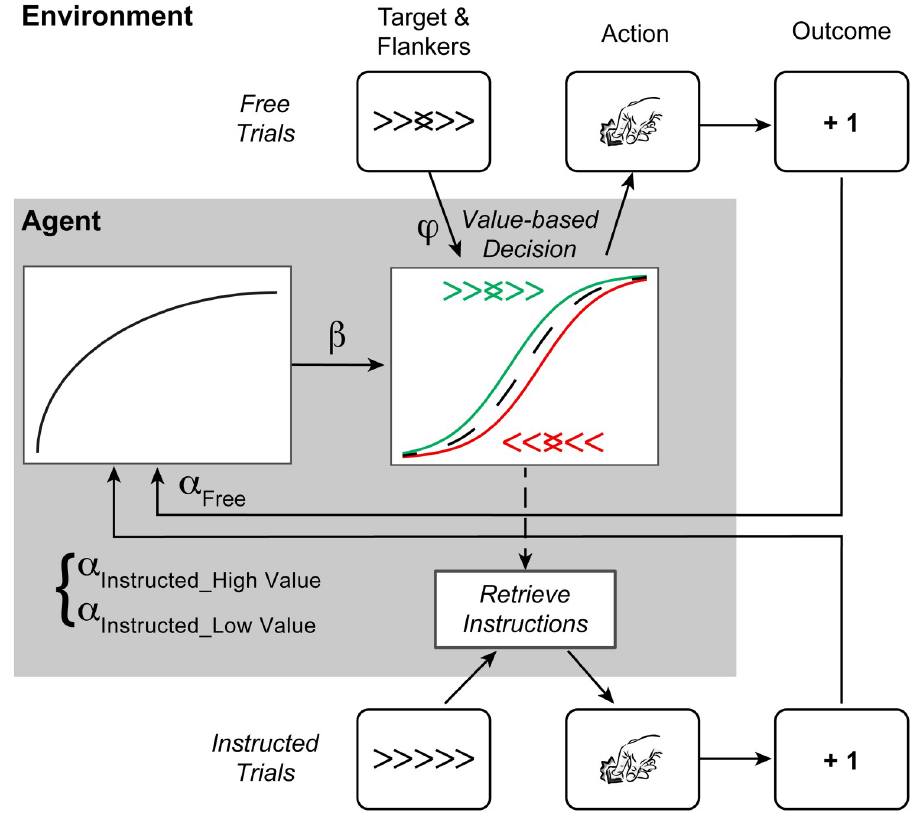
Fig 5. Schematic representation of the winning computational model. In Free trials, participants make value-based decisions by integrating internal information about action values (as a function of the temperature parameter, β ) with the external suggestion of the distractors (as a function of the distractor bias parameter, φ ). The distractor bias parameter captures the increased the likelihood that participants will choose actions that are congruent with the distractors, especially when the difference in action values is small (i.e. larger gap between green/red lines in the middle of the graph of the value-based decision, see also Fig 3B). This can be interpreted as reflecting the participants’ tendency to avoid conflict, and its associated cognitive control demands, especially when the expected benefits are low. The outcomes of those freely chosen actions can then be used to update action values (as a function of the learning rate, α Free ). In instructed trials, participants must retrieve the instruction of following the target direction, but the accumulated action value information may partially interfere with their responses (influence on RTs seen in Fig 3D). Moreover, action outcomes are used to update actions values differently depending on whether the instruction required making the subjectively high vs. low value action ( α Instructed_High Value vs. α Instructed_Low Value respectively, based on the previously accumulated